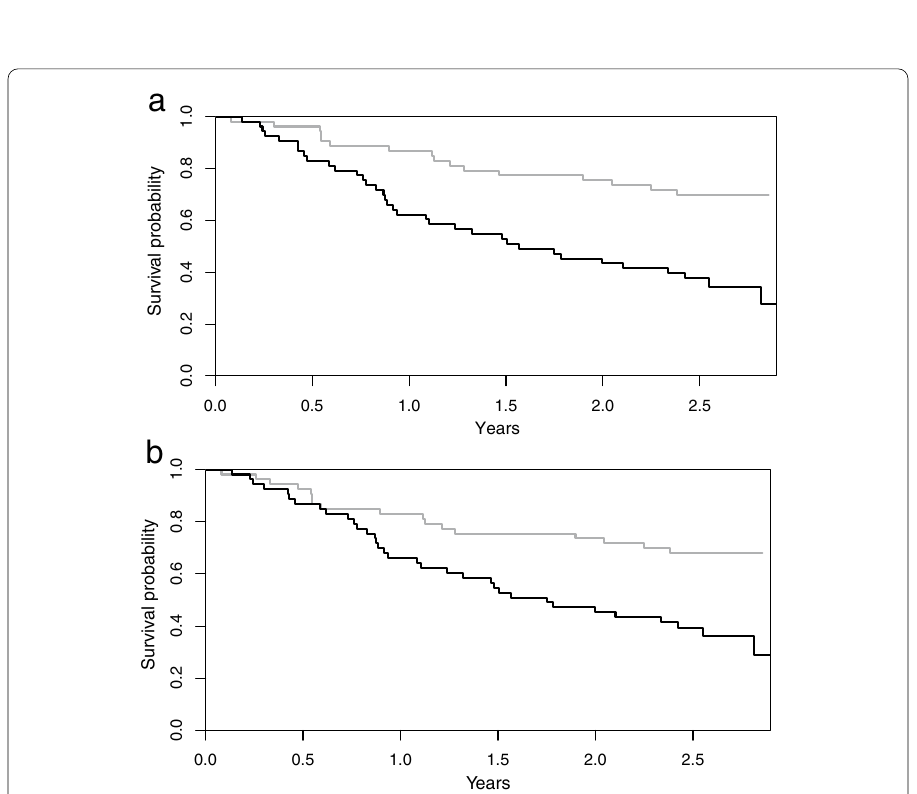
Fig. 3 Kaplan–Meier curves for the groups higher (black line) vs. lower (grey line) than the median TLG values for CNN TLG ( a ) and manual TLG ( b